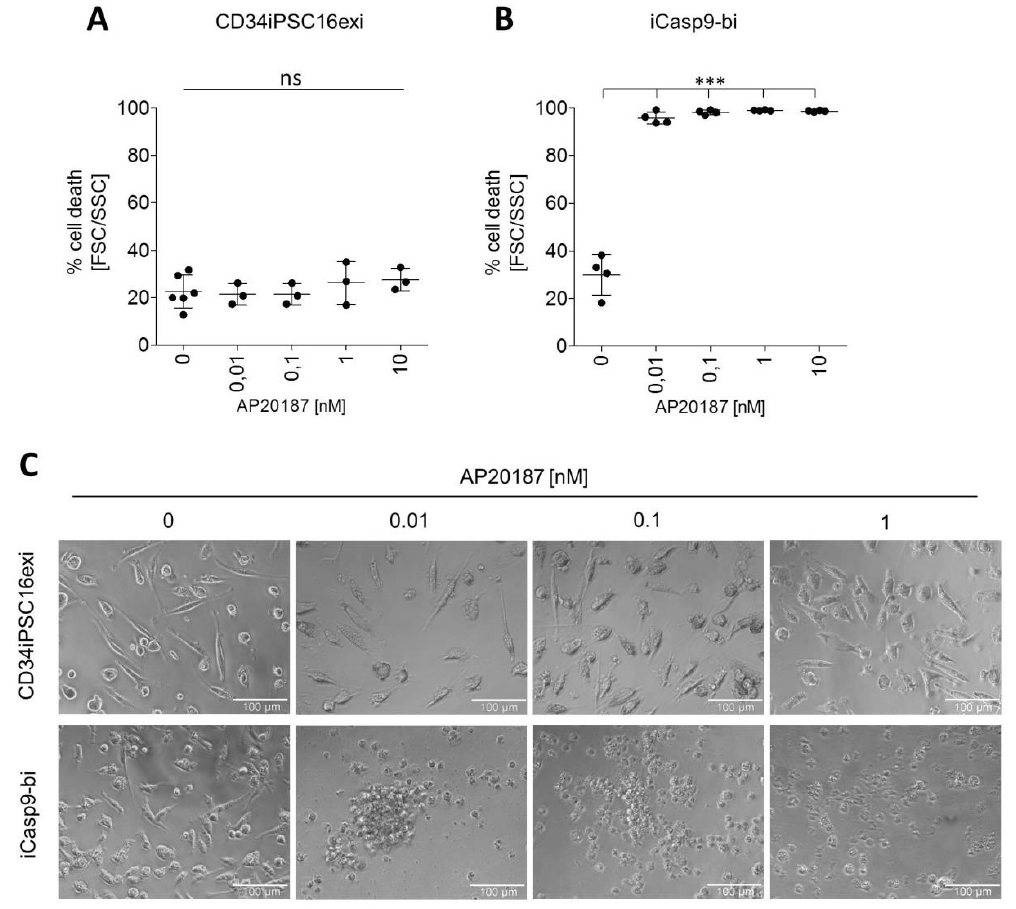
Figure 4. Induced killing of the iCasp9-expressing iMΦ. Percentage of dead cells according to FSC/SSC gating 24 h after application of 0 to 10 nm AP20187 in CD34iPSC16exi iMΦ ( A ) and iCasp9-bi iMΦ ( B ). (mean ± SD, ***P <0.0001, ns—non significant) ( C ) Phase-contrast imaging of the iMΦ 24 h after treatment with different concentrations of AP20187. (scale bar—100 µm).